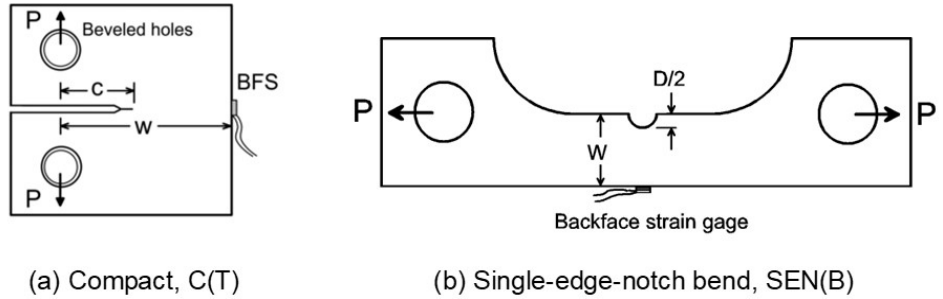
Figure 1. Fatigue-crack-growth and fatigue specimens tested and analyzed.